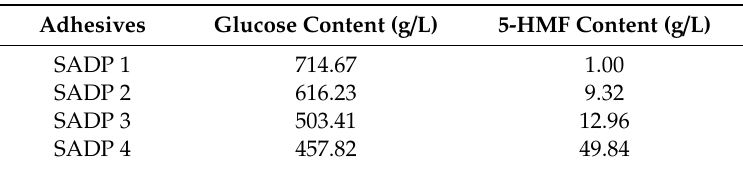
Table 4. Wood failure of the three ‐ ply plywood bonded with SADP adhesives at different hot pressing temperatures.